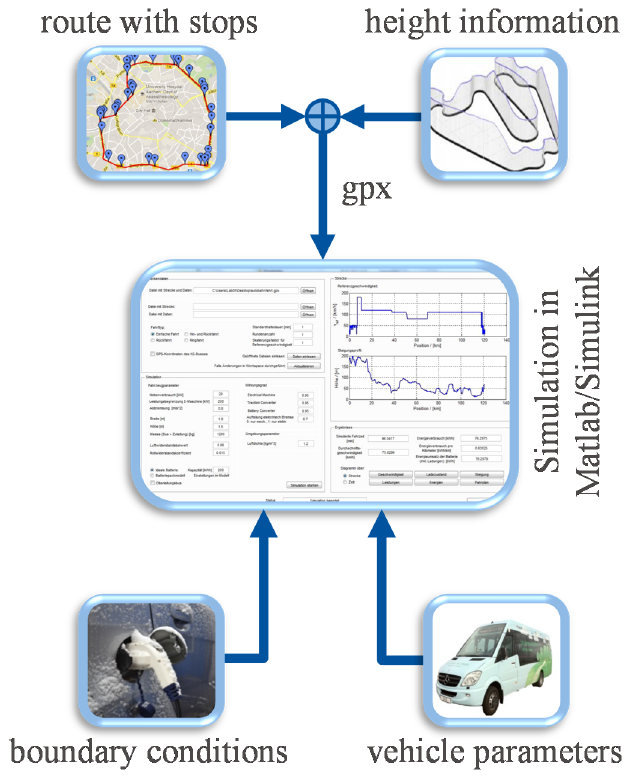
Figure 3. Matlab/Simulink tool for the demand analysis of the bus route using Google